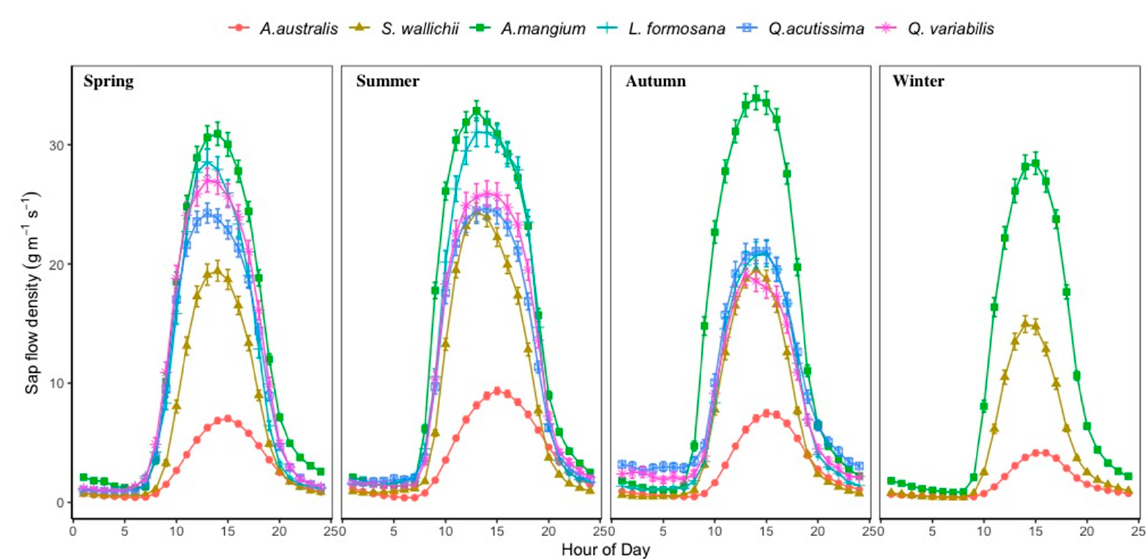
Figure 3. Average diurnal patterns of Fd at the outer most sapwood area on our sample trees for six dominant species during two years of study period. Error bars represent ± standard error. Winter Fd patterns for L. formosana , Q. acutissima and Q. variabills are not available because measurements were suspended during winter time at CJGS research site.